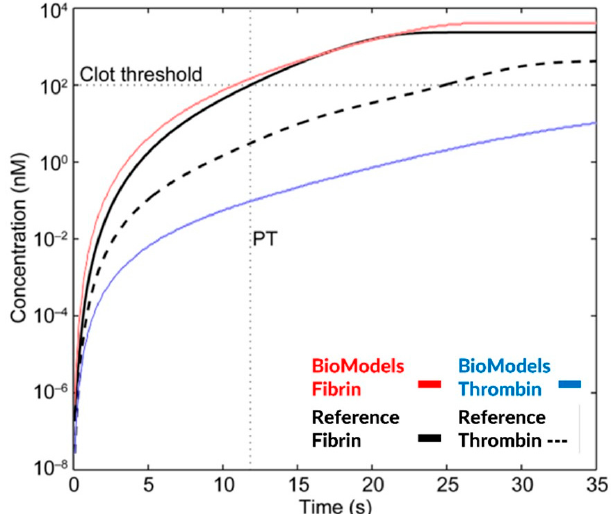
Figure 6. Simulation of a prothrombin time test (PT) based on thrombin and fibrin generation for the Burghaus model [4] and the related BioModels code repository [1]. Fibrin concentrations are similar; however, the thrombin generation curve is significantly different between the simulation results of the published and the publicly available model